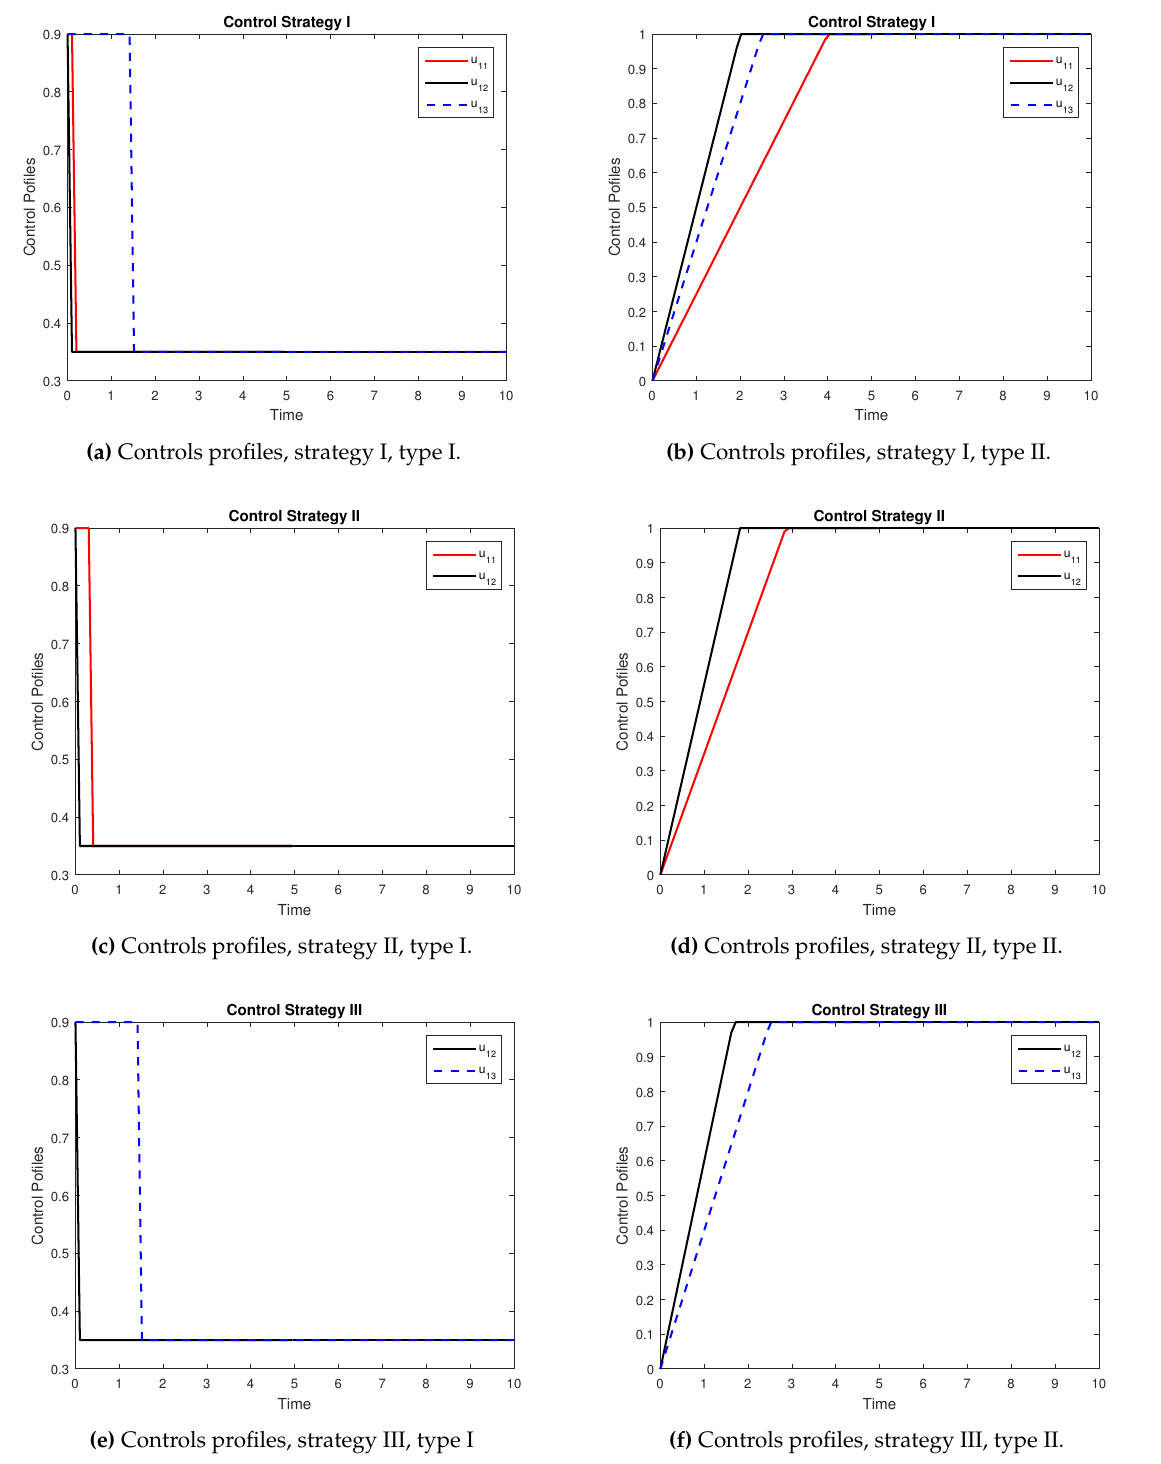
Figure 2. The profiles of the controls associated with resistance in the different strategies and for the different types of